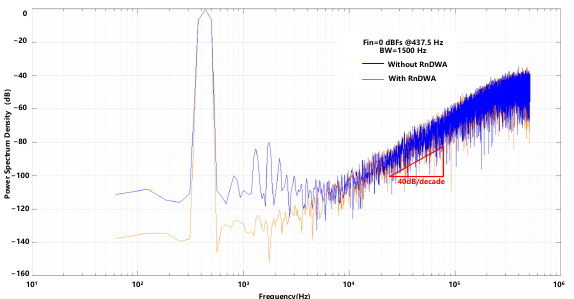
Figure 14. The power spectrum of the modulator with/without the RnDWA.